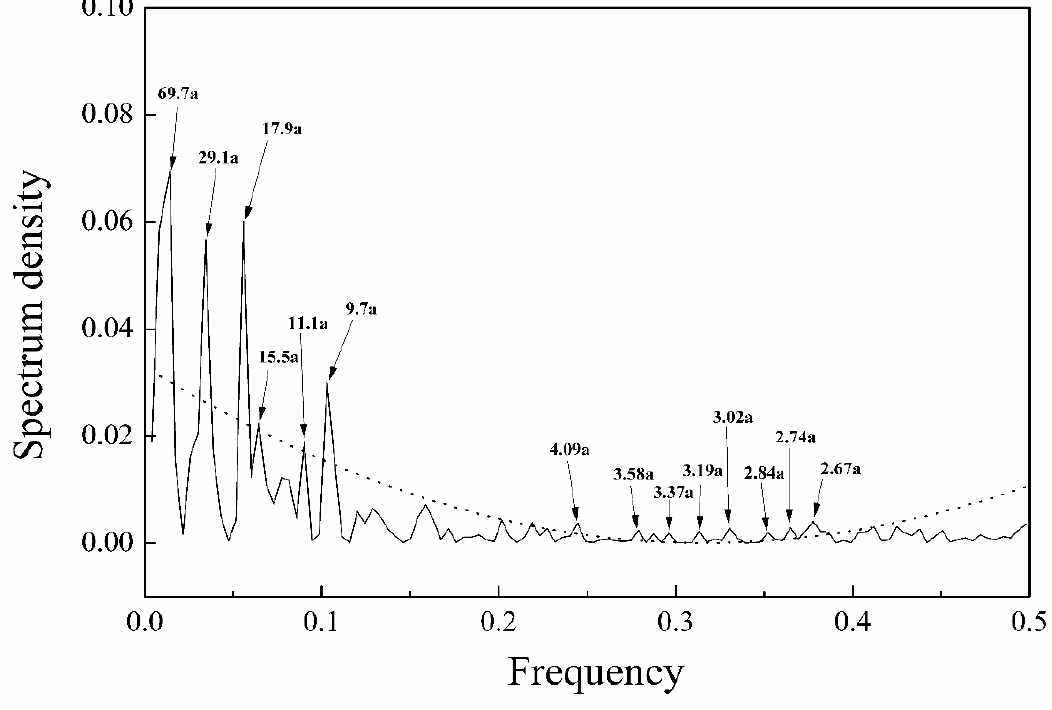
Figure 7. The power spectrum analyses of reconstructed June–July mean maximum temperature. The 95% confidence limits for peaks in the power spectrum are indicated by the dash lines.